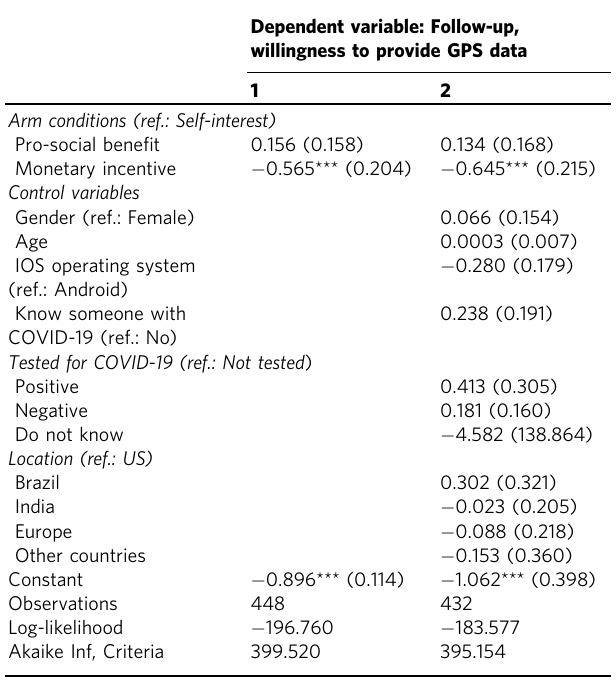
Table 3 Determinants of the acceptance of the Vickrey auction procedure.